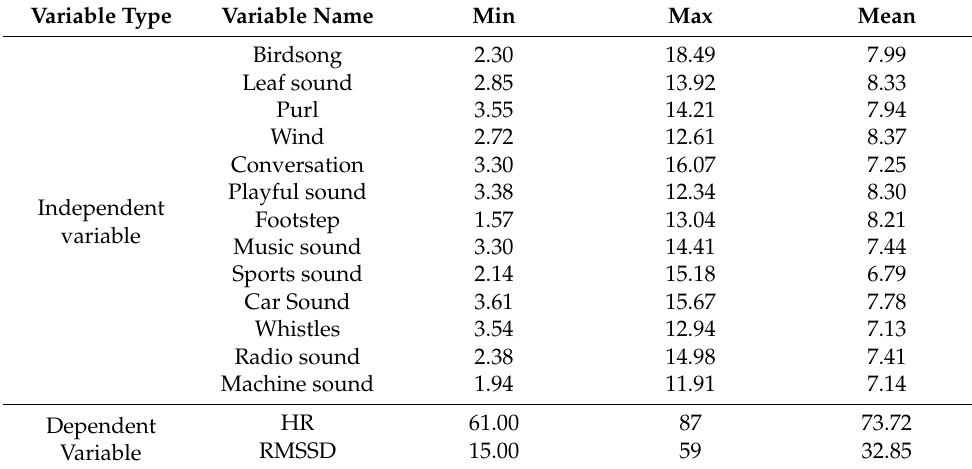
Table 5. Descriptive statistics of variable data.